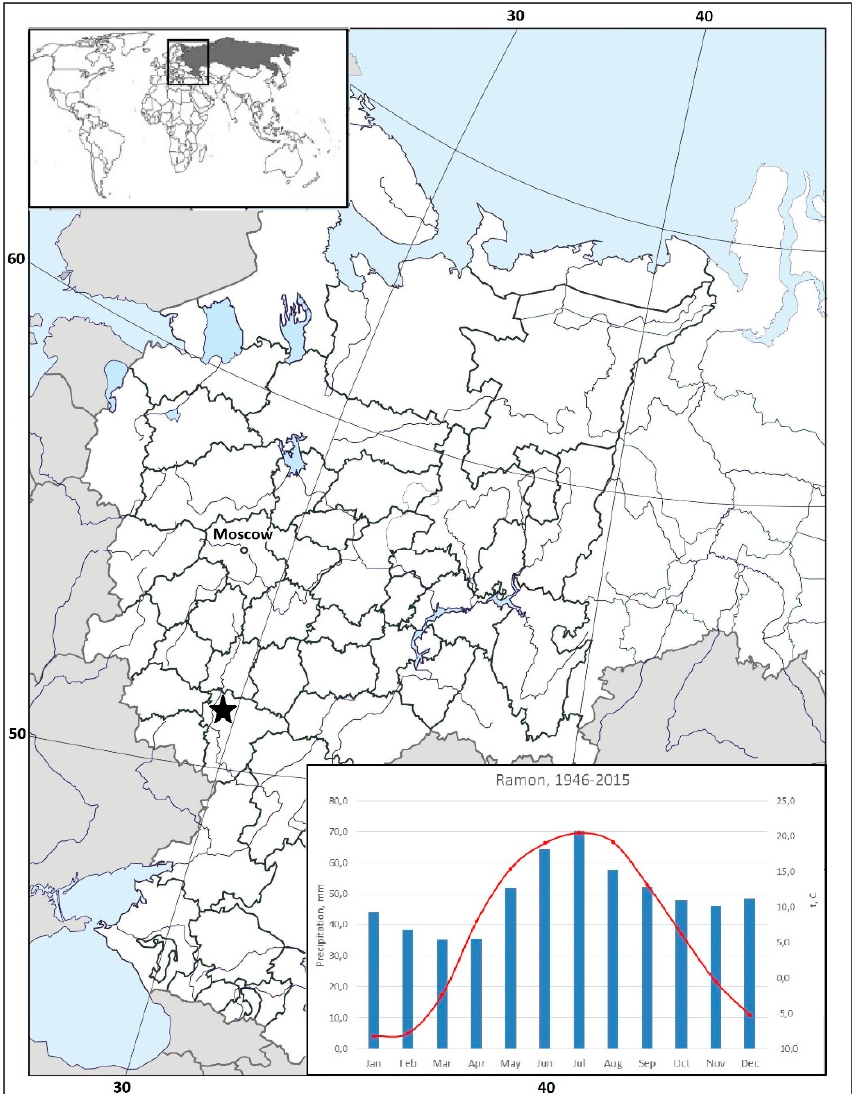
Figure 1. The location and a climatic diagram for the VNIISS experimental field. Ramon, Voronezh region, is the closest meteorological station to the field. Table 1. E ff ect of fertilization on selected soil properties in the VNIISS experiment (2013). Table 2. Statistical evaluation of the results of modelling the dynamics of organic carbon reserves using the Roth-C model in the long-term experiment of VNIISS.